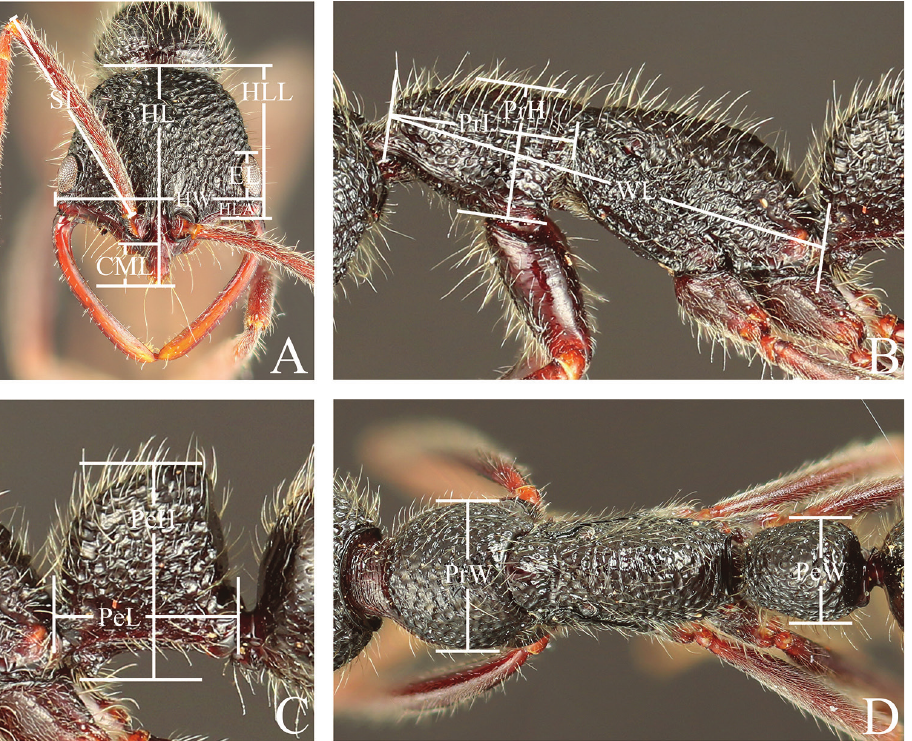
Figure 1. Measurements of worker of the Leptogenys modiglianii species group. A Head, full-face view B lateral view C petiole, lateral view D dorsal view. Abbreviations : HL: Head length, HLL Head lateral margin length, HLA Anterior head length, HW Head width, CML Clypeal median lobe length, SL Scape length, EL Eye length, PrL Pronotum length, PrH Pronotum height, PrW Pronotum width, WL Weber’s length, PeL Petiole length, PeH Petiole height, PeW Petiole width. HW Head width: in full-face view, the maximum width of the head excluding the eyes. CML Clypeal median lobe length: in full-face view, the straight-line length measured from the anterior margin of the clypeus to the anterior margin of the torulus. CI Cephalic index: HW/HL × 100. CLI Clypeus index: CML/HL × 100. SL Scape length: the straight-line length of the first antennal segment, excluding the neck and the basal condyle. SI Scape index: SL/HW × 100. EL Eye length: in full-face view, the vertical line length of the compound eye. OI Ocular index: EL/HLL × 100. PrL Pronotum length: in profile, the diagonal length of the pronotum, measured from the anterior margin of the pronotum excluding the collar to the posterior extremity of the